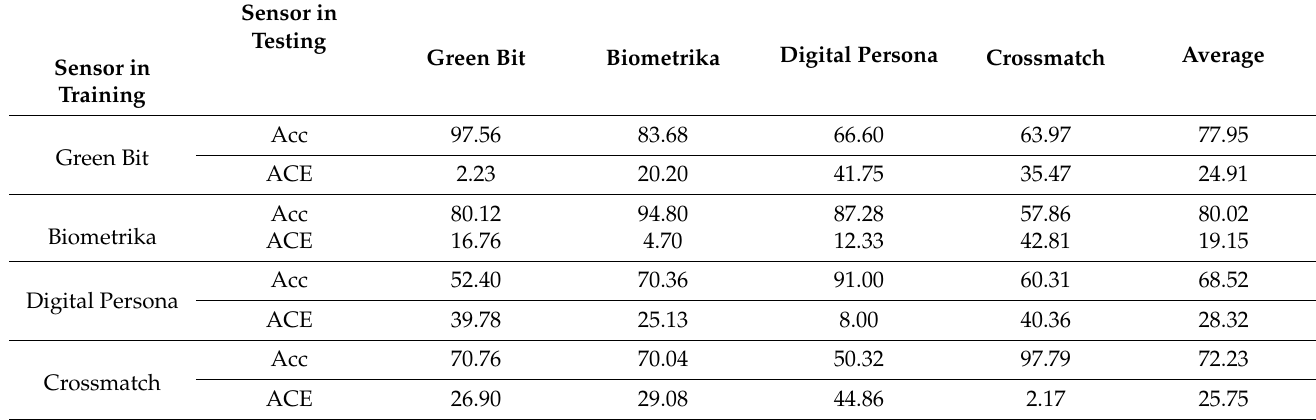
Table 4. The generalization performance among cross-sensors on LivDet 2015 in terms of classification accuracy (acc%) and average classification error (ACE). Sensor in Green Bit Biometrika Digital Persona